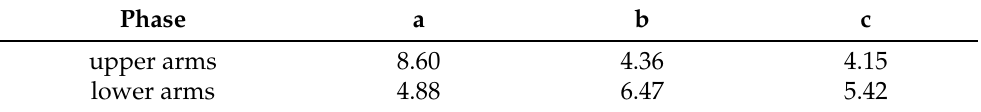
Table 8. Surge current integral ( MA 2 · s ) for D 2 in Converter 1 with AC circuit-breakers.